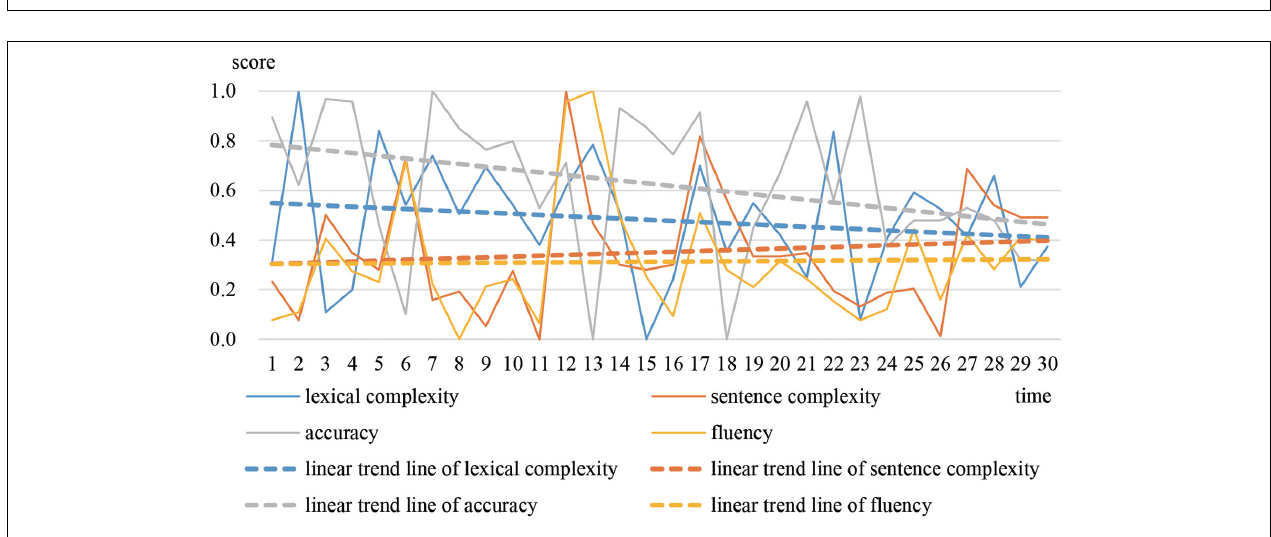
FIGURE 5 | Moving correlations of Adam’s accuracy and other three subsystems.